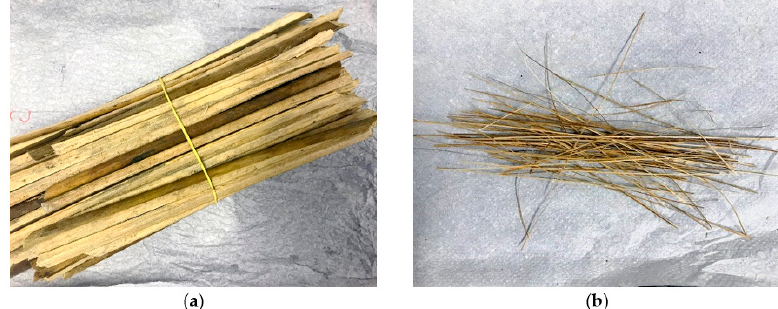
Figure 1. Defibrillation process of caranan fibers ( a ) leaf-stalk ( b ) defibrilated caranan fibers.